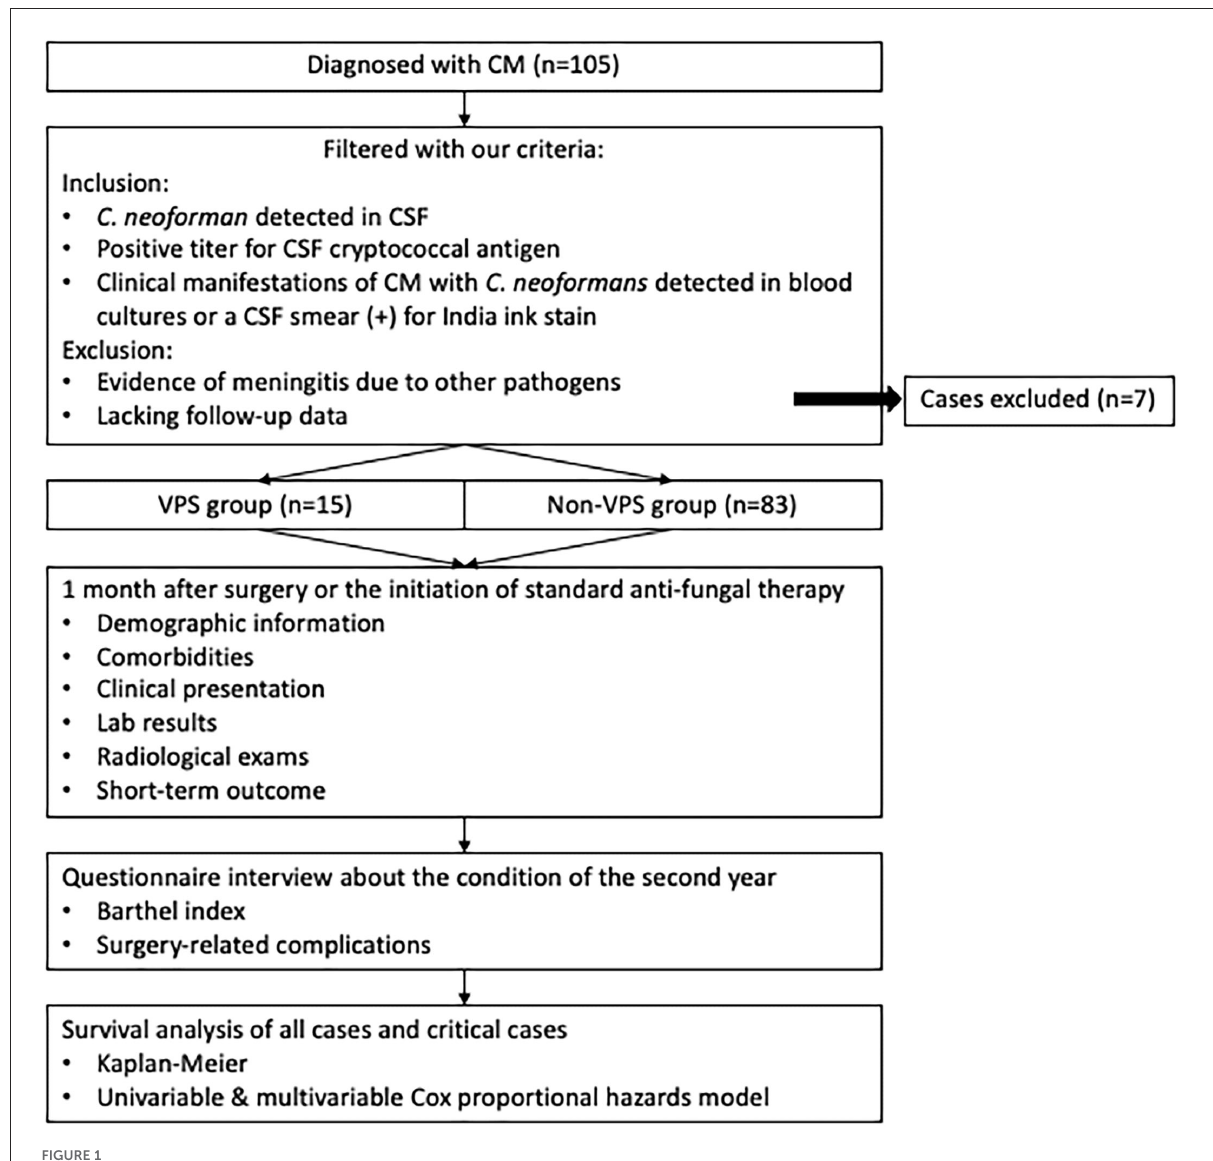
FIGURE1 Study flow